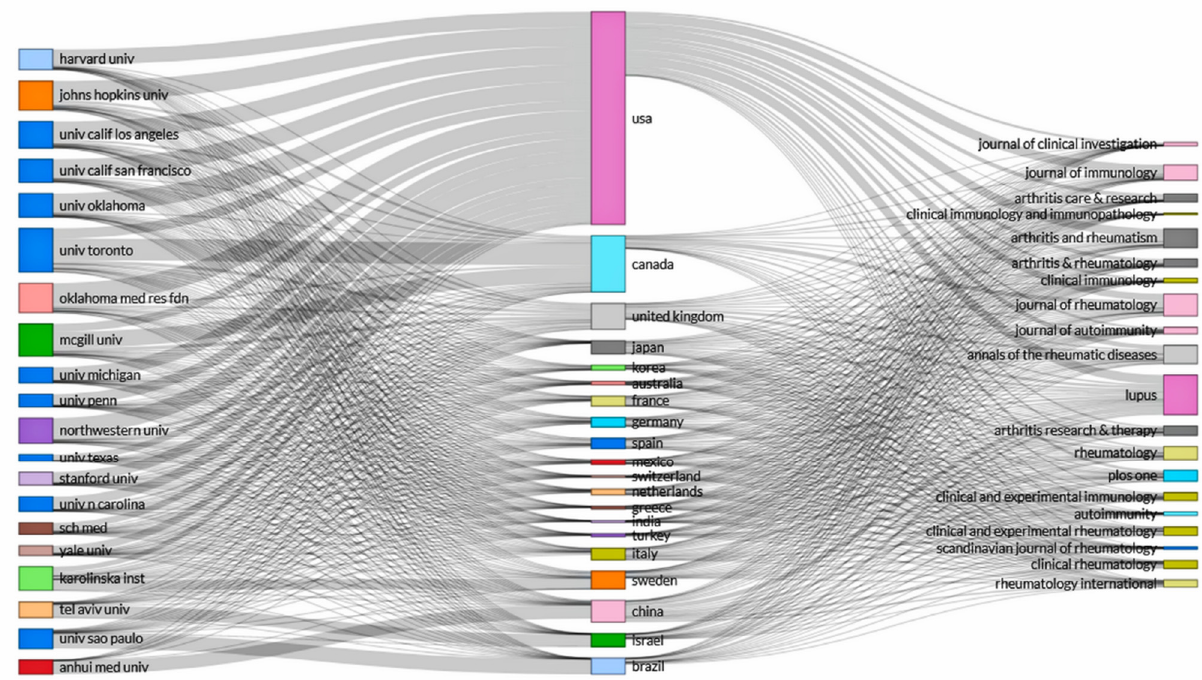
Figure 6. A three-field plot showing the network between institutions ( left ), countries ( middle ), and journals ( right ) of original articles on systemic lupus erythematosus from 1971 to 2020.